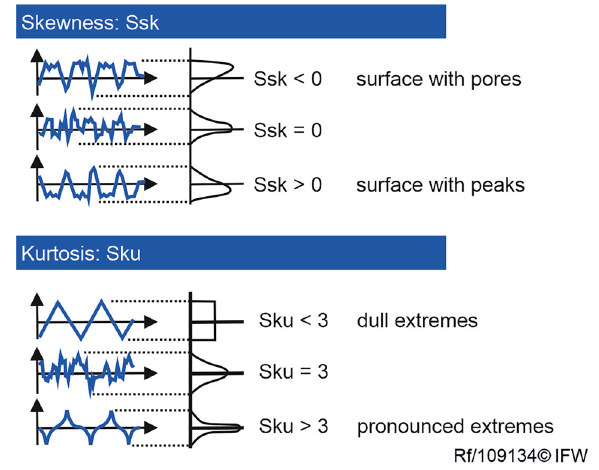
Fig. 3 Description of surface parameters Ssk and